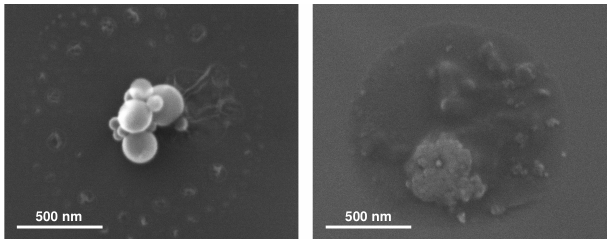
Figure 6. Secondary electron images of droplets with their typical morphology of a halo around a